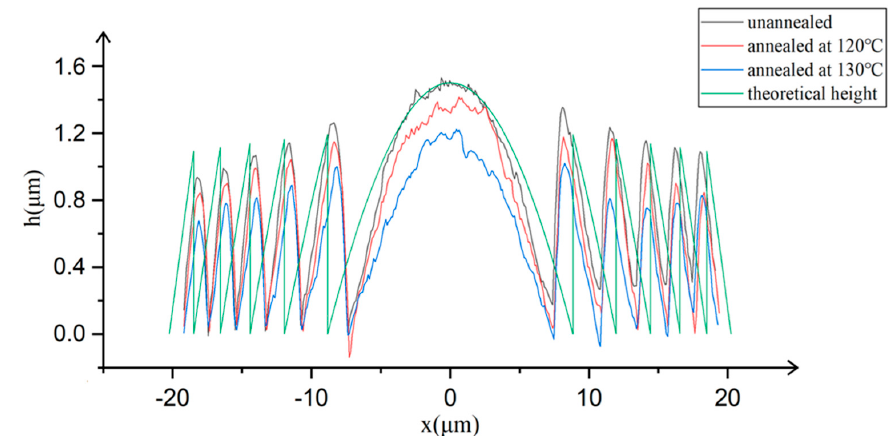
Figure 5. Surface profiles along the diameters of the Fresnel lenses. The green curve is the theoretical value of the desired Fresnel lens. The black, red and blue curves are results of the Fresnel lenses unannealed, annealed at 120 °C and 130 °C, respectively.